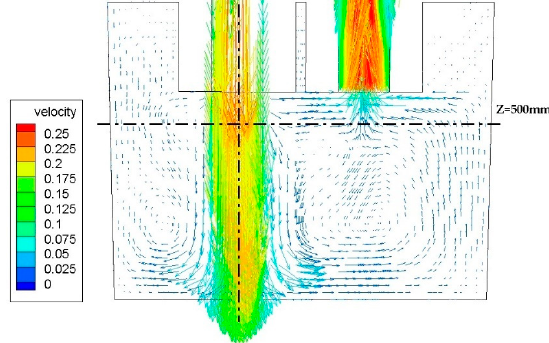
Figure 4. Velocity vector on symmetrical plane of RH model ladle. Metals 2020 , 10 , x FOR PEER REVIEW